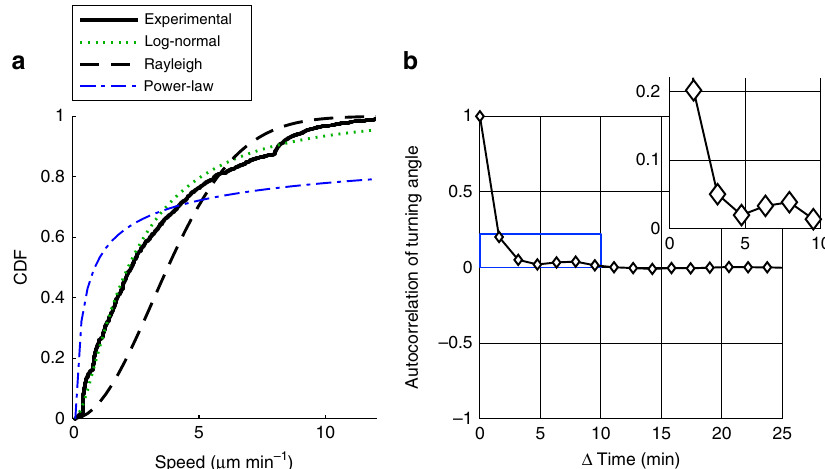
Fig. 3 Migration of lung-in fi ltrating T cells is correlated and fi ts a lognormal distribution. GFP + effector T cells were injected i.v. into LPS-treated mice. After two to fi ve days, lungs were explanted and imaged with two-photon microscopy. Tracks with a duration of 120 min were analyzed. a Shown are the cumulative distribution functions (CDF) of experimentally measured speeds from 2960 frame-to-frame migration steps and of the fi ts of various mathematical models. b Autocorrelation of turning angle. Analyses were performed on 37 tracks pooled from three independent